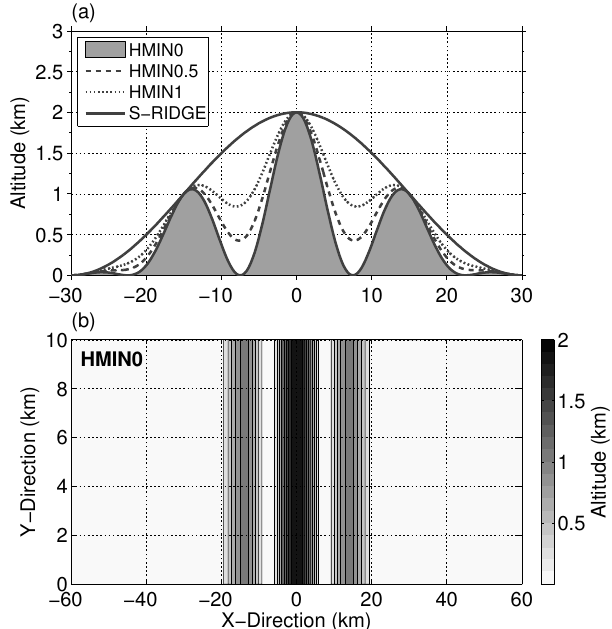
Figure 1. Idealized model topography of the reference run HMIN0 as (a) vertical cross section (gray shading) and (b) plan view (show- ing the full domain). Additional topography setups with three ridges and different elevated valley floor heights, and with a single ridge are used in sensitivity simulations and are shown in (a) as dashed, dotted and solid lines (compare Table 1).